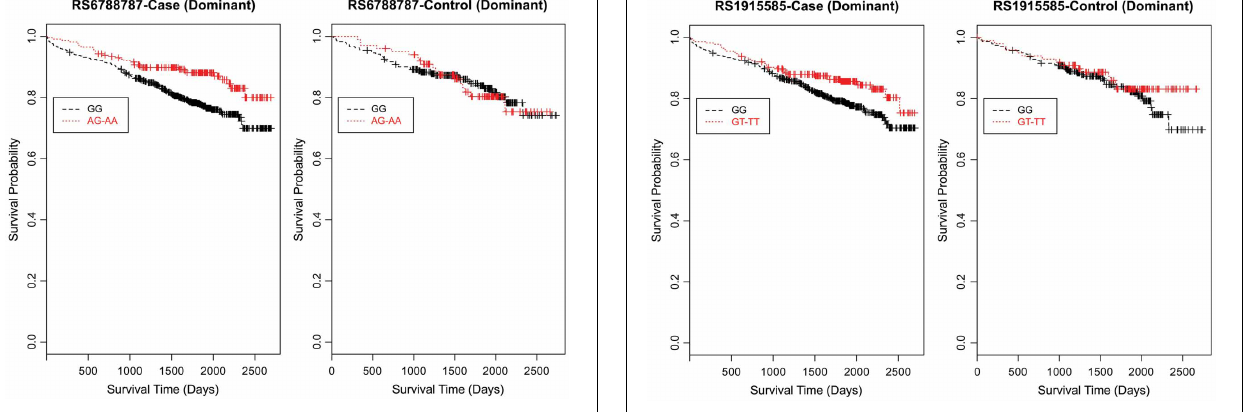
similar to rs6788787 for both additive and dominant models. To